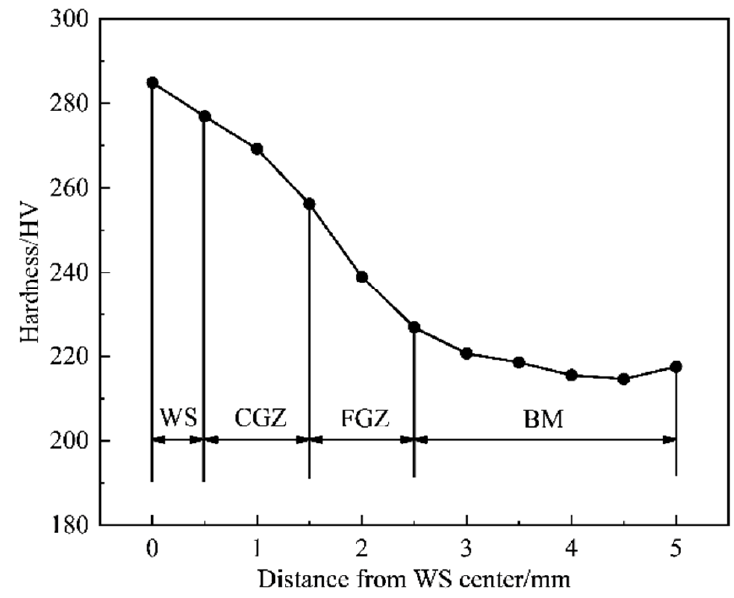
Figure 5. Hardness distribution of the welded joint.